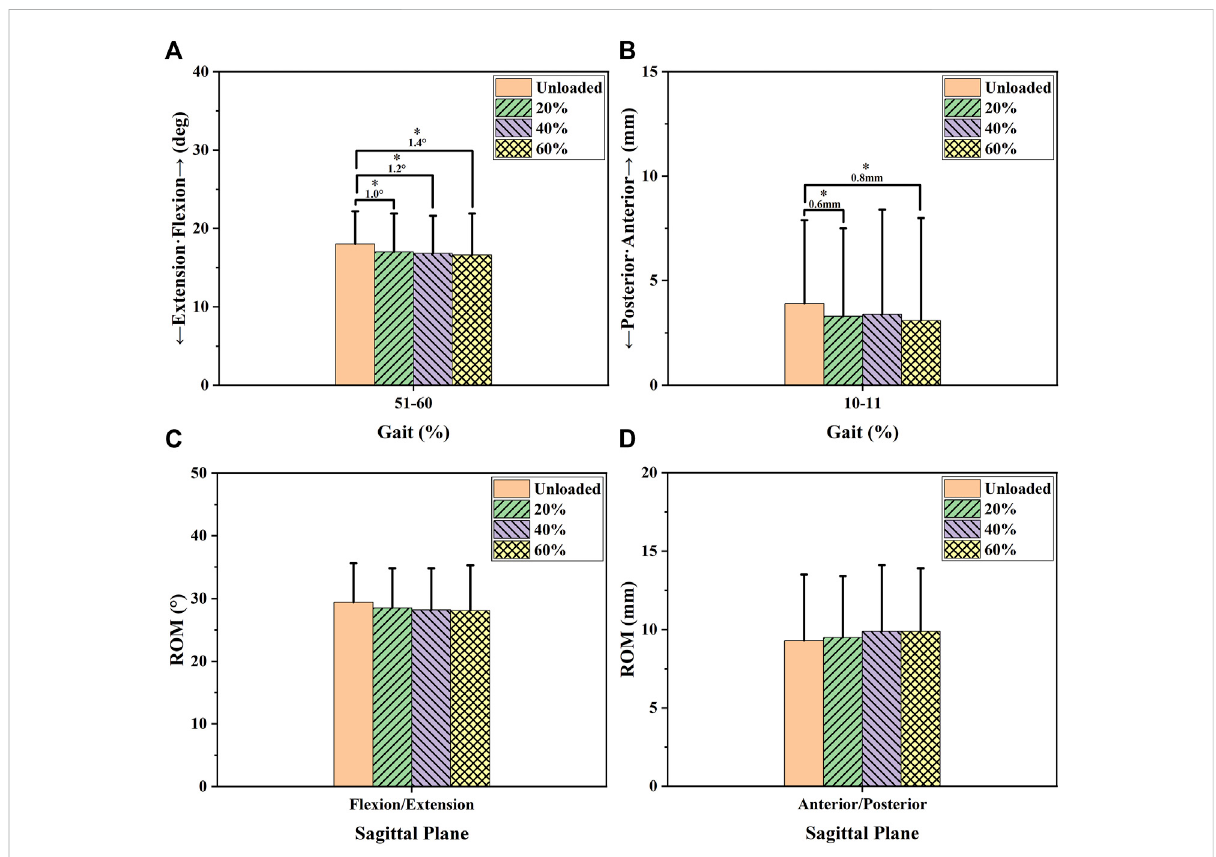
FIGURE 5 Sagittal ROM and average knee kinematic alterations during the phases affected by increased load levels. Charts (A and B) show the average knee kinematics of the affected phases (i.e., the phases marked by colored bars in Figure 2) under increased load levels. Charts (C and D) show the ROM of sagittal knee kinematics under increased load levels. The differences in the knee kinematics between the unloaded state and load levels of 20, 40, and 60%BW were compared using a statistical signi fi cance level of 0.05. The number and * in the chart represent the differences in magnitude and signi fi cant differences between the groups ( p <